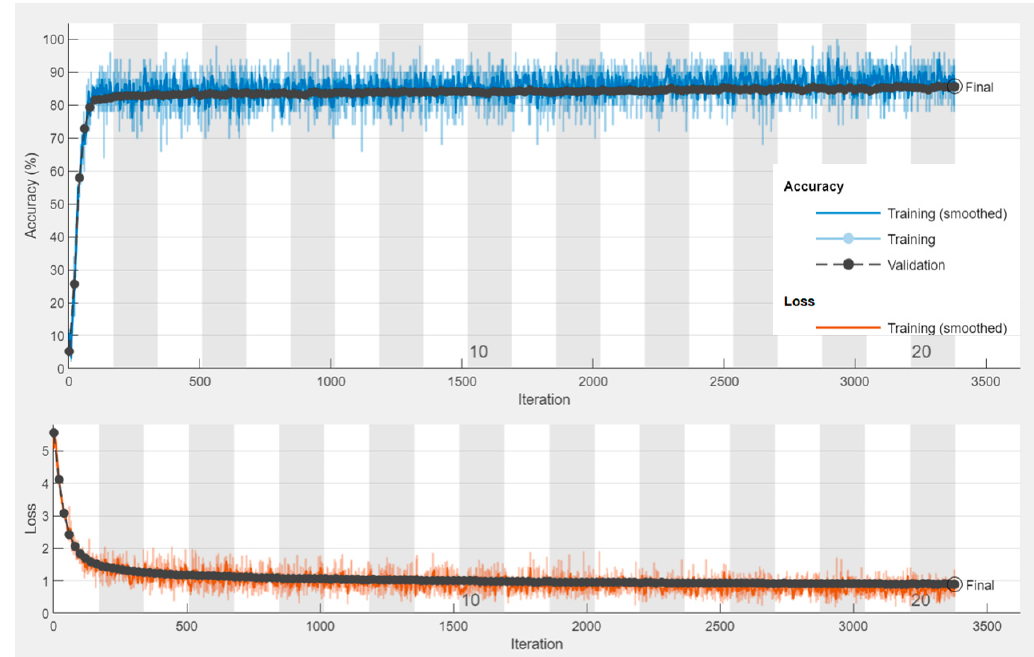
Figure 6. The training progress plot for the 313 th cluster, generated by MATLAB.